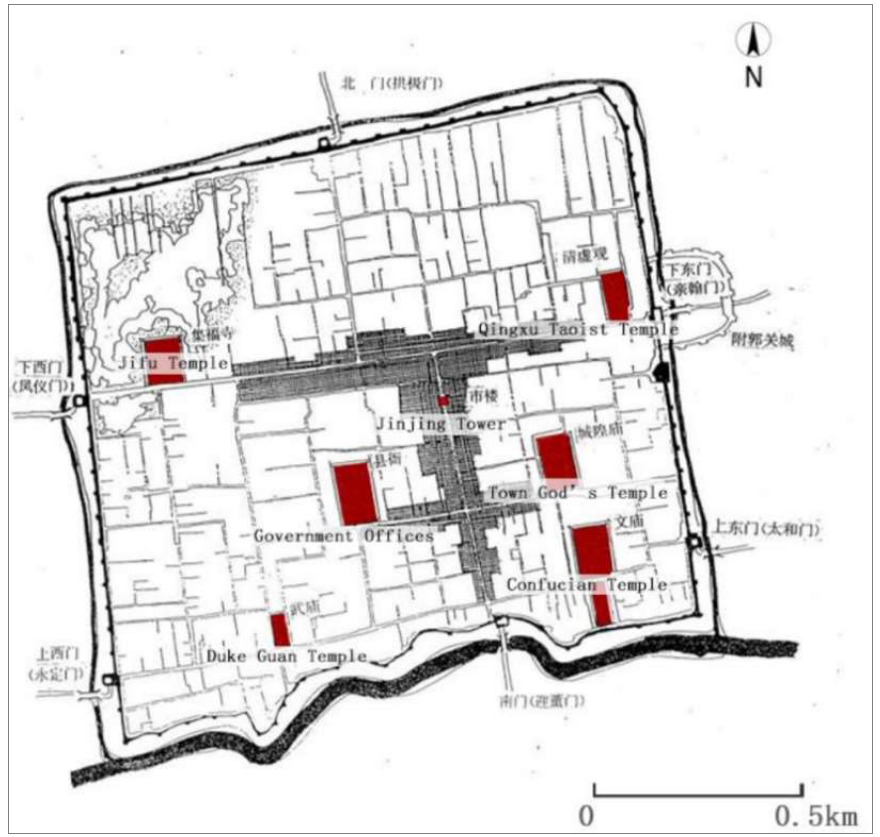
Figure 8. Spatial structure map of Pingyao Ancient City. (Adapted according to the Pingyao Historical and Cultural City Protection Plan (1989) provided by the Department of Housing and Urban-Rural Development of Shanxi Province).